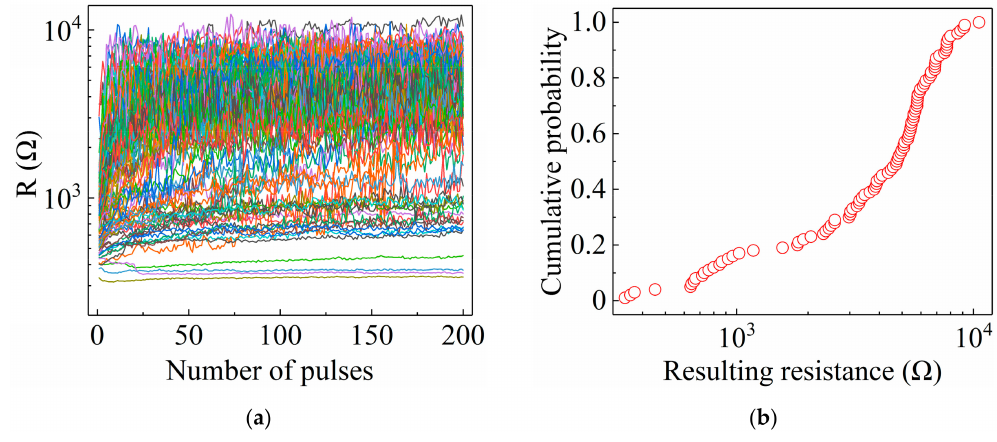
Figure 5. ( a ) Variability of device resistance for 100 trains of 200 RESET pulses. The applied pulses were 0.9 V in amplitude and 100 µ s in width. The device was in the LRS before the application of each train of pulses. ( b ) Cumulative probability distribution of device resistance after 200 RESET